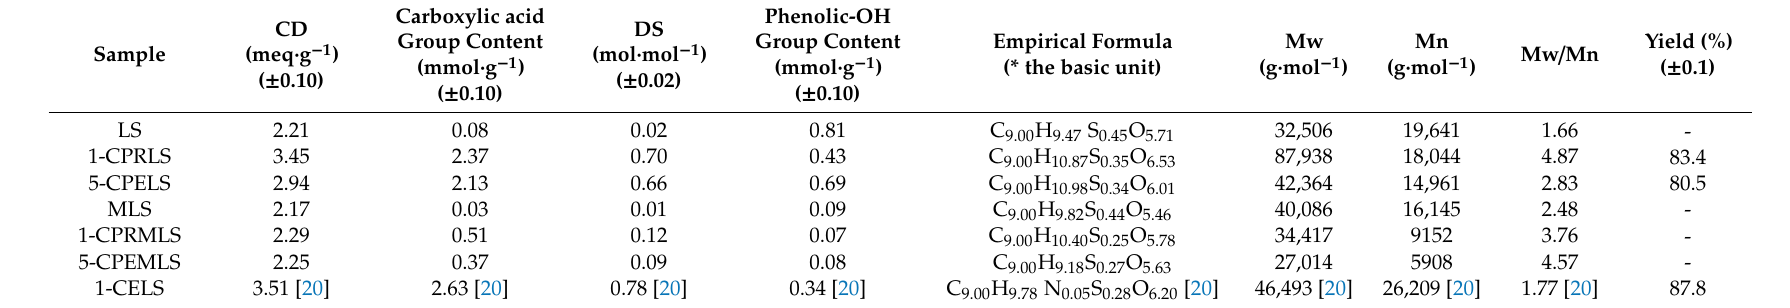
Table 3. Properties of LS, 1-CPRLS, 5-CPELS, MLS, 1-CPRMLS, and